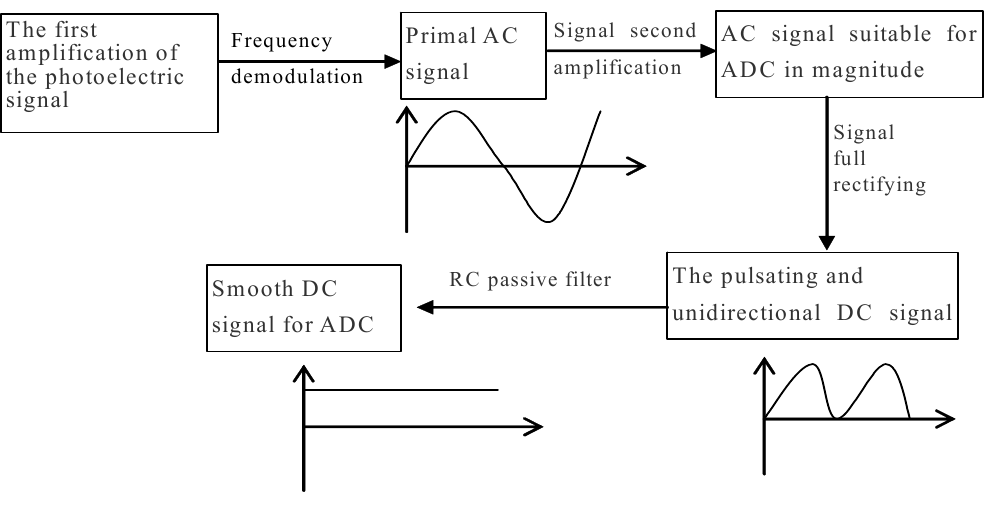
Figure 5. Flow diagram of the signal